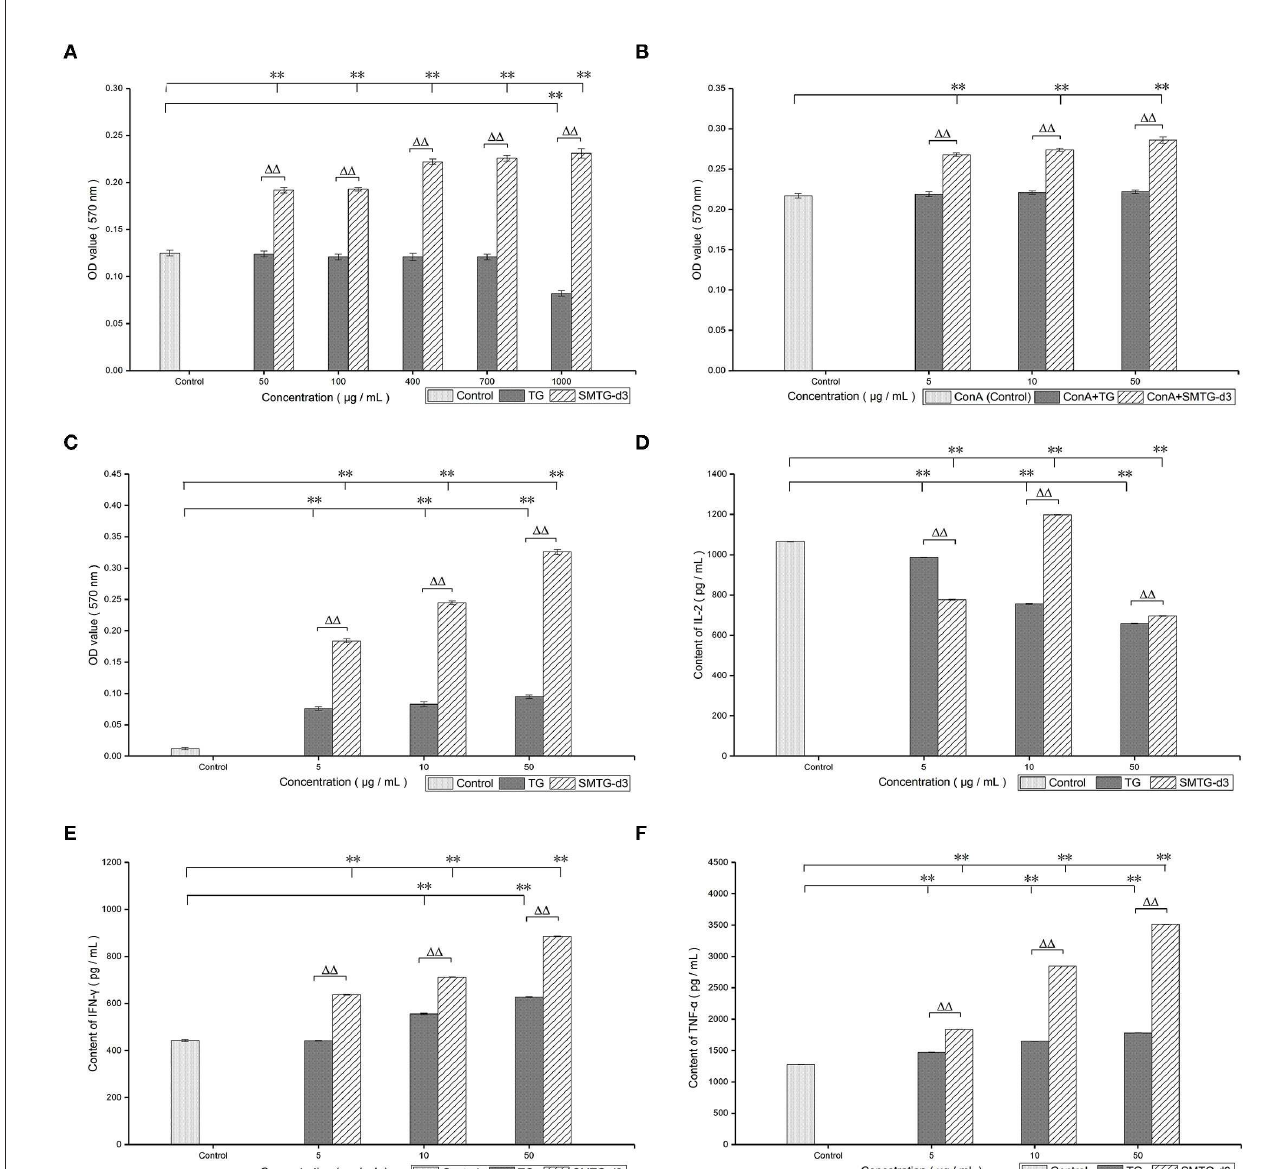
FIGURE2 In vitro immunological activity of TG and SMTG-d3. Data are presented as mean ± SD. (A) Assay of cytotoxic concentration; (B) T-lymphocyte proliferation; (C) NK-cell activity; (D) IL-2 production; (E) IFN- γ production; (F) TNF- α production. * P < 0.05, ** P < 0.01, compared with the control group. 1 P < 0.05, 11 P < 0.01, compared with the TG group of the same concentration. TG, total ginsenosides; SMTG-d3, sulphation-modified total ginsenosides